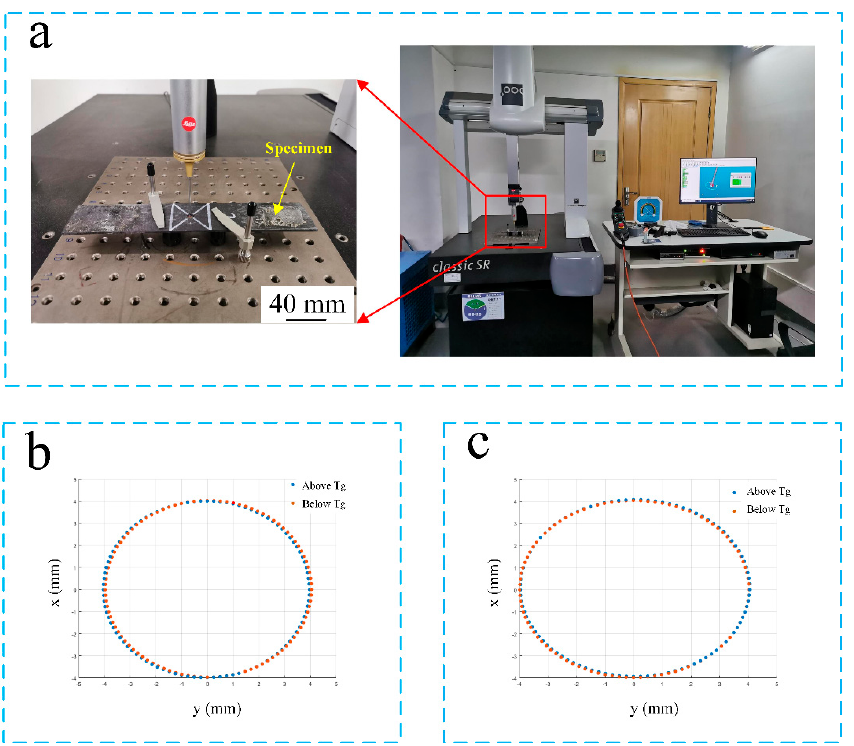
Figure 7. ( a ) Three-coordinate measuring machine used for testing deflection of a drilled hole after ten thousand cycles; ( b ) 2D distribution of a target point for tensile/tensile fatigue tests after ten thousand cycles; and ( c ) 2D distribution of a target point for compressive/compressive fatigue tests after ten thousand cycles. Table 2. Roundness of untreated and cryo-treated CFRP specimens.